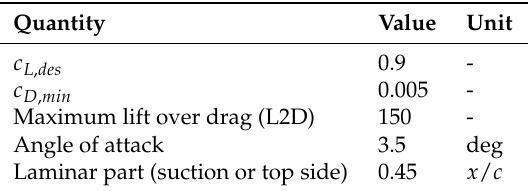
Table 1. Assumed operation point for profile at R = 35, from Xfoil